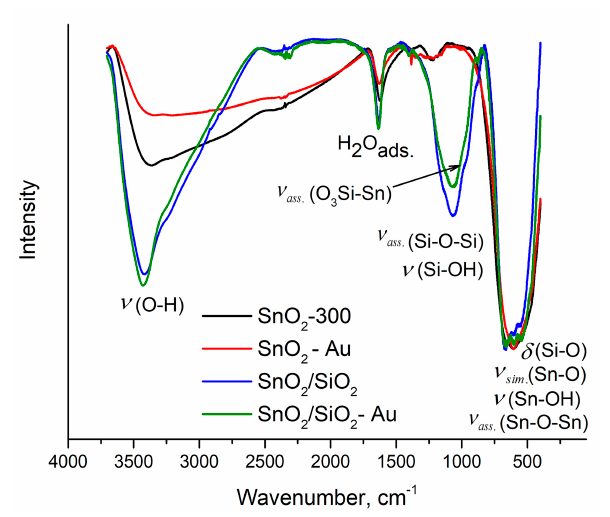
Figure 4. IR-spectra of SnO 2 -300, SnO 2 -Au, SnO 2 / SiO 2 and SnO 2 / SiO 2 -Au samples.